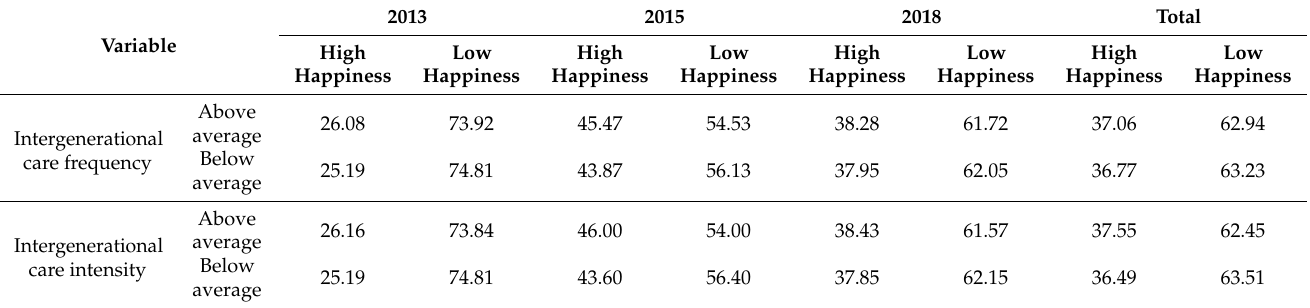
Table 2. Well-being of elderly farmers under different intergenerational care situations (%).